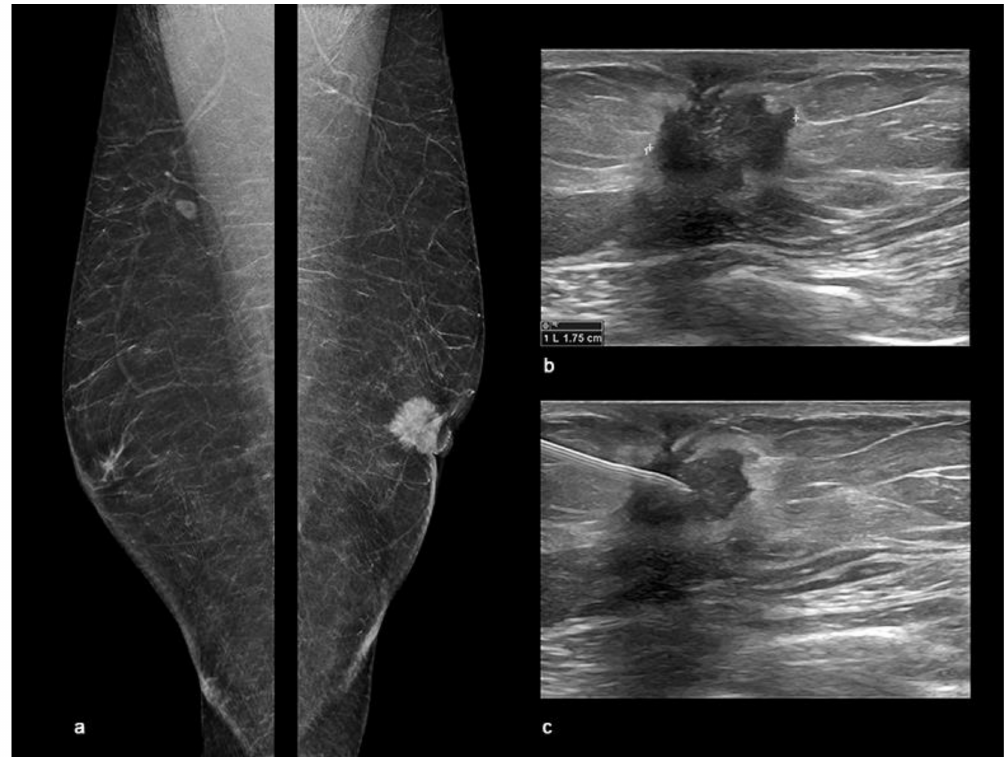
Figure 8. Male Breast Cancer. Digital breast tomosynthesis (DBT) and ultrasound (US) showing an invasive ductal carcinoma of the left breast in a 58-year-old male observed at our department with a palpable retro-areolar mass and nipple retraction at clinical examination. ( a ) The synthetic 2D reconstructed medio-lateral-oblique images (s2D-MLO) showed a sub-areolar dense mass with spiculated margins and skin retraction. ( b ) US showed a left retro-areolar, hypoechoic mass with indistinct border and spiculated margins of 1.75 cm. ( c ) US-guided Fine-Needle Aspiration Cytology (FNAC) resulting C5 according to the the IAC Yokohama System for Reporting Breast Fine-Needle Aspiration Biopsy Cytopathology (1st Edition,